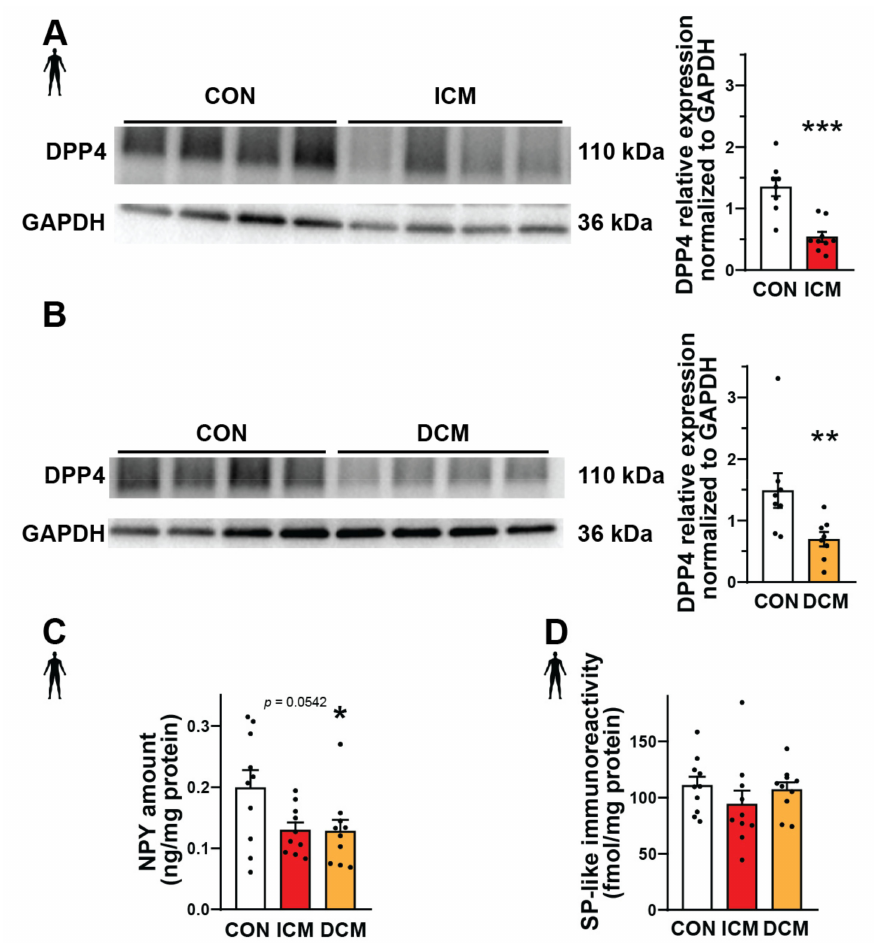
Figure 1. Protein expression of DPP4 and neuropeptides in failing human heart samples. Western blot analysis of DPP4 enzyme ( A , B ), ELISA ( C ), and radioimmunoassay ( D ). Quantification ( A − D ) of the DPP4 and neuropeptide substrates (NPY and SP) content in interventricular septum samples of healthy patients (CON) or patients with ischemic (ICM) or dilated cardiomyopathy (DCM). One-way ANOVA with Tukey’s post hoc test, unpaired t -test, and Mann–Whitney test * p < 0.05, ** p < 0.01, *** p < 0.001 vs. CON, group size: n = 8–10. Data are expressed as mean ±